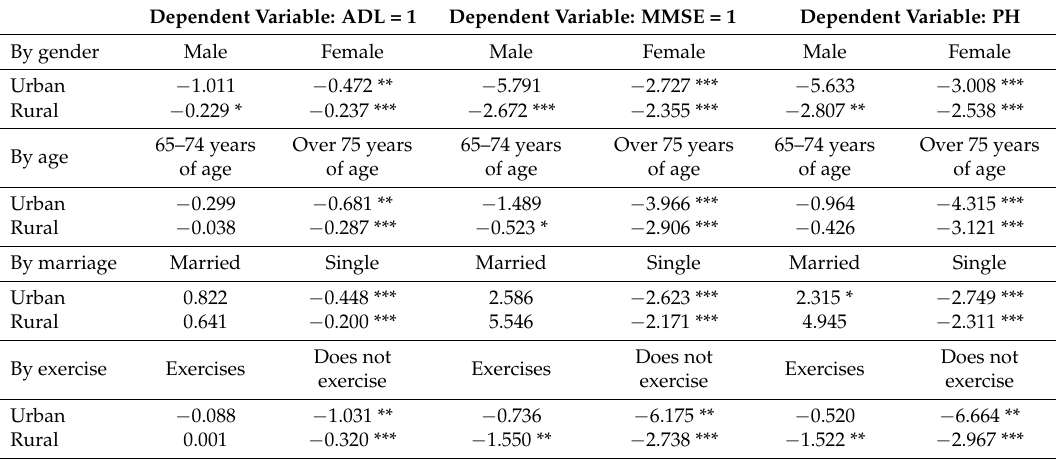
Table 7. Effect of an empty nest on elders’ health in different